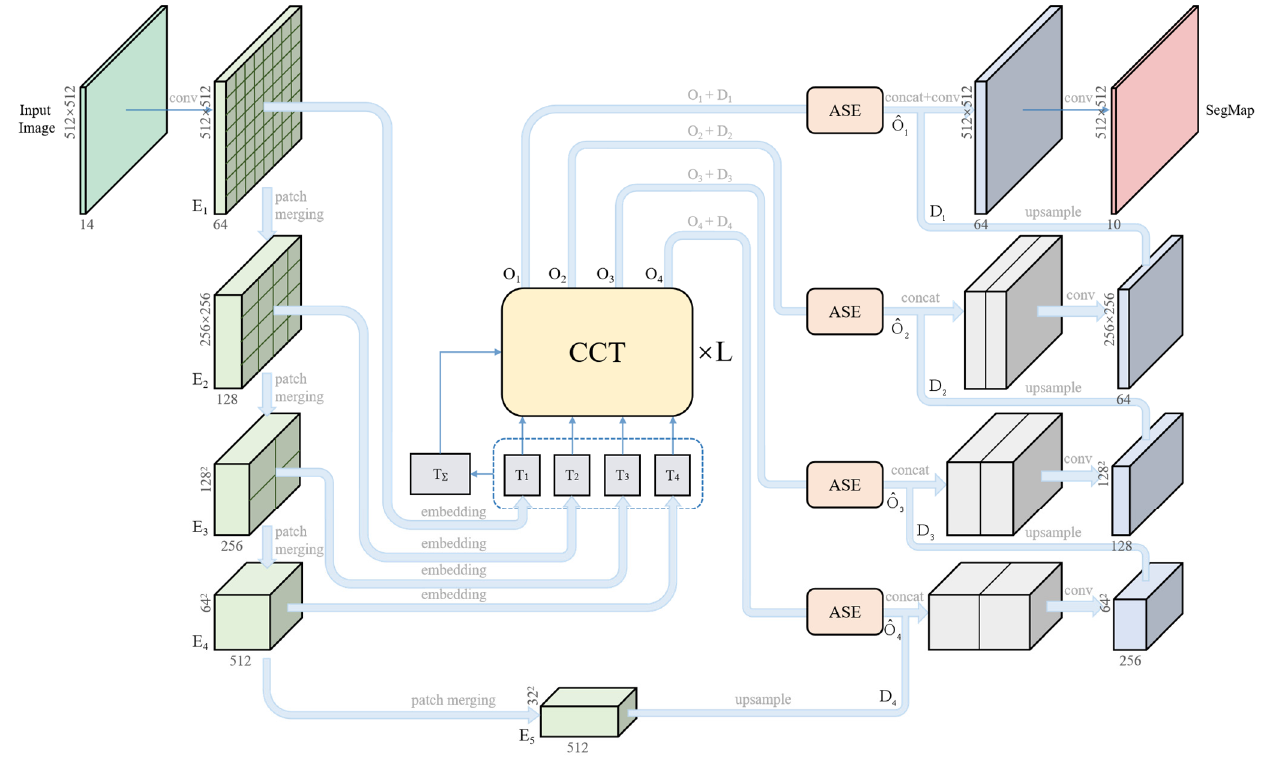
Figure 4. The architecture of UATNet. CCT and ASE are Channel-wise Cross fusion Transformer and Attention-based Squeeze and Excitation, respectively.